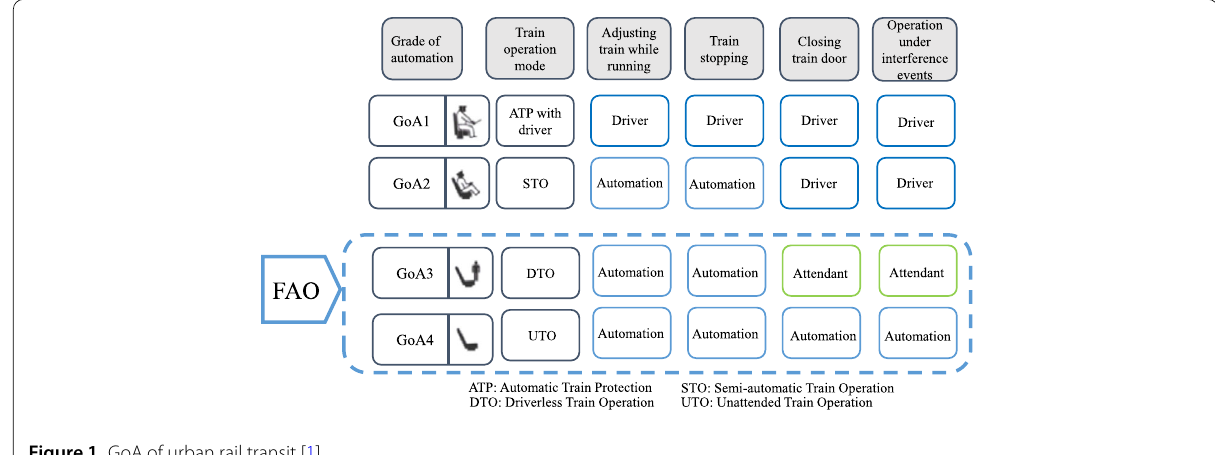
Figure 1 GoA of urban rail transit